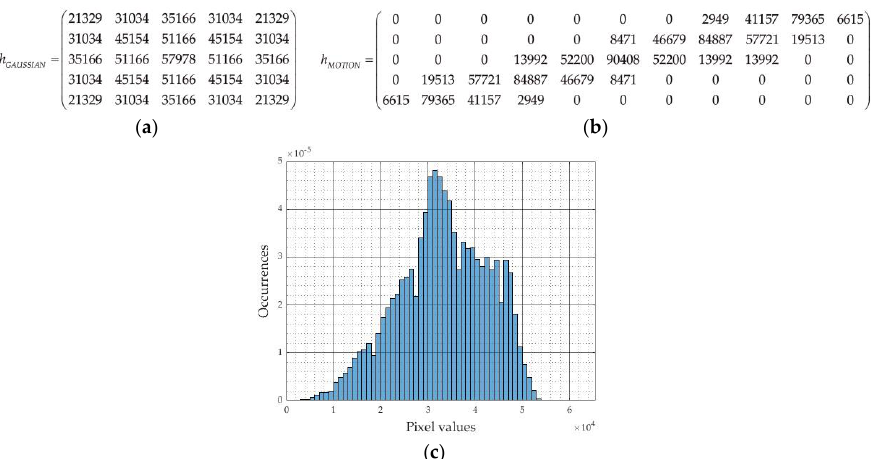
Figure 7. Kernel matrix for ( a ) the gaussian and ( b ) the motion filter. ( c ) Histogram of occurrences for the Mandrill image.